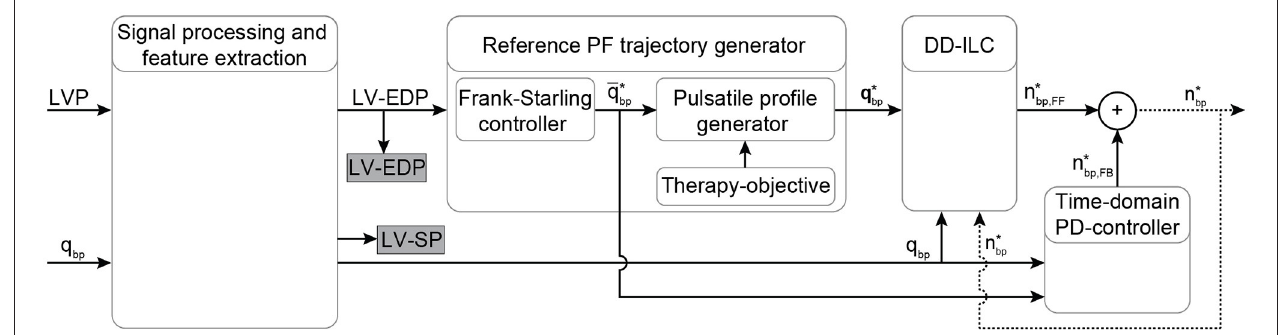
FIGURE 1 | Schematic overview of the physiological data-driven iterative learning controller. The input signals LVP and PF are filtered and the EDP and SP indices are extracted from the LVP. Based on the Frank-starling mechanism, the desired average PF is calculated based on the LV-EDP that is used as a preload surrogate, and the reference pulsatile PF trajectory is obtained based on the objectives of the therapy. A data-driven iterative learning controller is implemented to achieve accurate tracking of the reference PF without requiring modeling of the CVS or the pump. Finally, a proportional-derivative (PD) controller is coupled coupled to enable feedback in the time-domain. The desired pump speed is the output of the controller. Bold letters define vectors. LVP, left ventricular pressure; EDP, end-diastolic pressure; SP, systolic pressure; PF, pump flow; q bp , measured pump flow; ¯ q * bp , heart cycle average pump flow; q * bp , time vector of the desired pump flow trajectory; n * bp , FF , feed forward desired pump speed; n * bp , FB , feedback desired pump speed; n * bp , desired pump speed